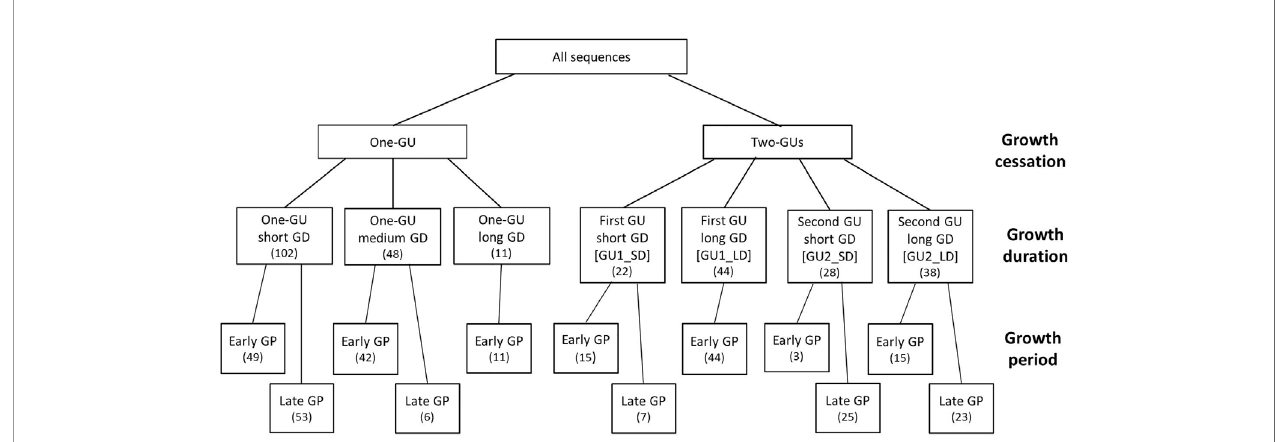
FIGURE 1 | Diagrammatic representation of shoot categories based on the existence of within-year growth cessation, growth duration (GD), and growth period (GP). The category with one-GU shoots was divided by GD thresholds of 30 and 90 days, and a GP threshold of June 3, 2016. Both GUs of two-GUs shoots were divided by a GD threshold of 30 days. Thresholds of GP were June 3, 2016 for the one-GU shoots and the fi rst GUs, and July 18, 2016 for the second GUs. The number of sequences for each category is in the